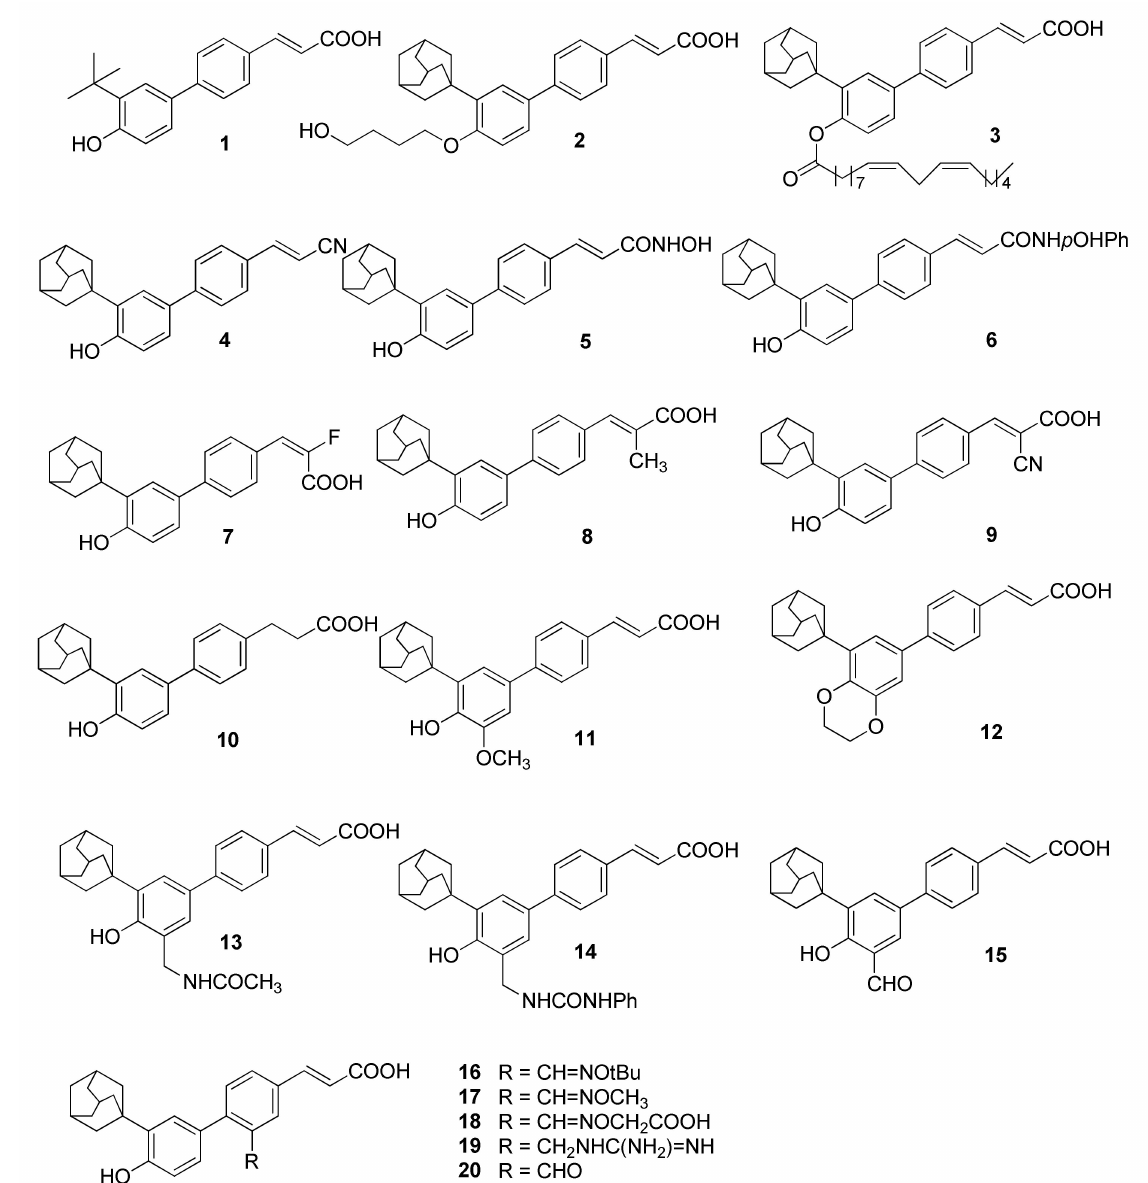
Figure 2. Structures of selected adarotene